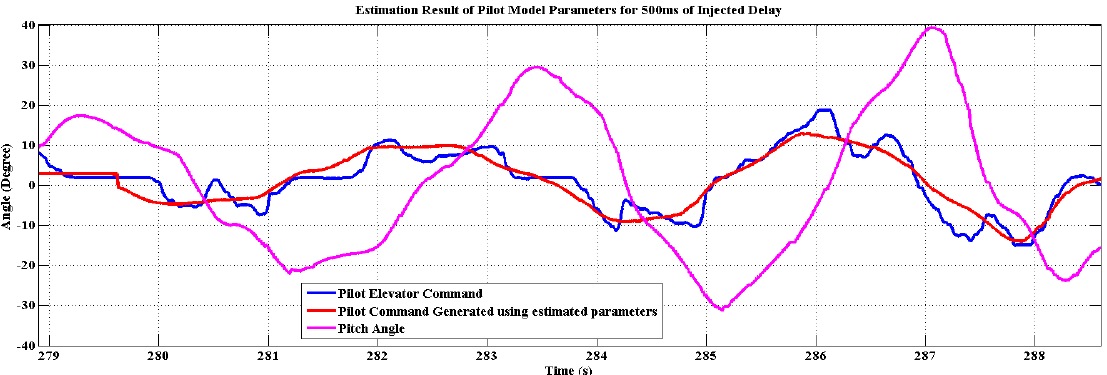
Figure 16. Pilot parameter estimation result for injected delay of 500